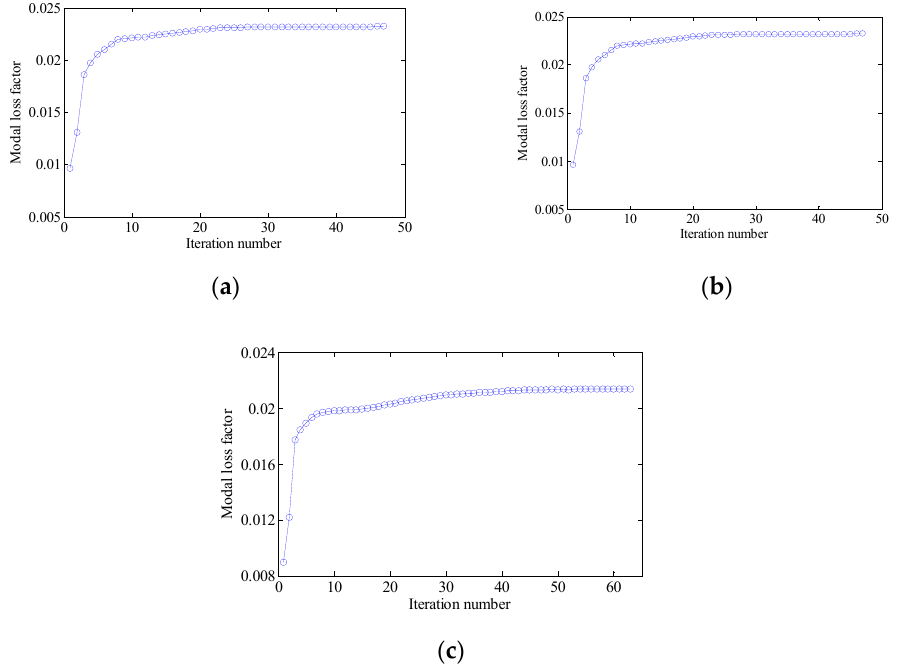
Figure 17. Iteration histories for maximizing the first modal loss factor: ( a ) Case 1: V MA